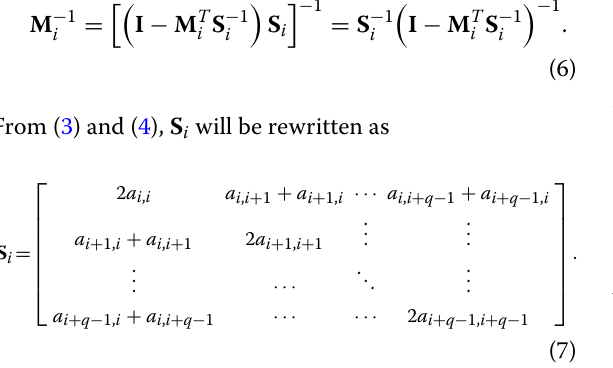
Algorithm 1 Proposed Channel